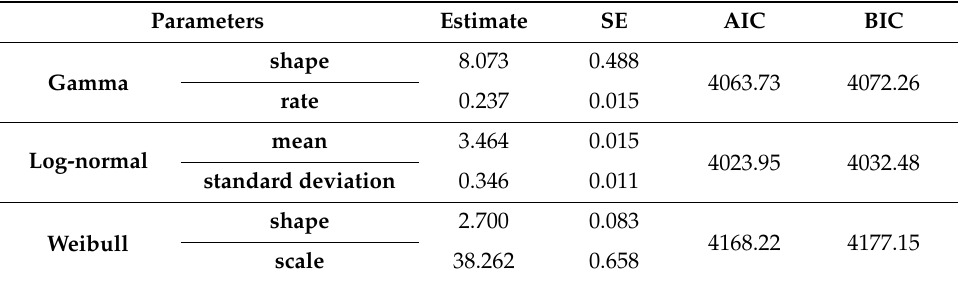
Table 2. Parameter estimates of probability distributions of Y-IAT.